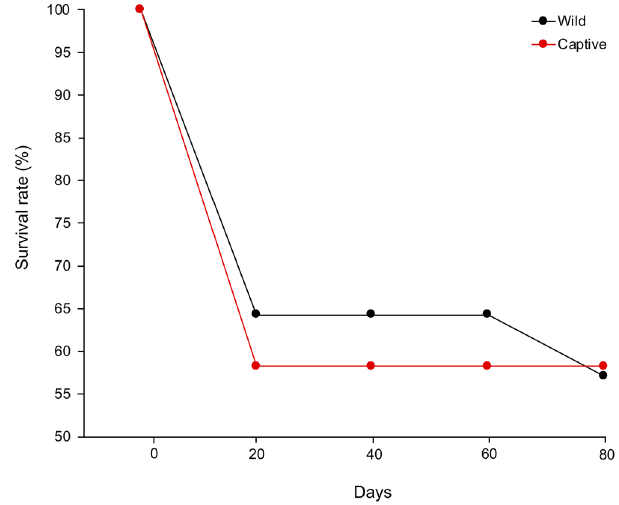
Figure 1: Survival rates in wild ( red line ) and captive ( black line ) postlarvae in the giant freshwater prawn Macrobrachium rosenbergii